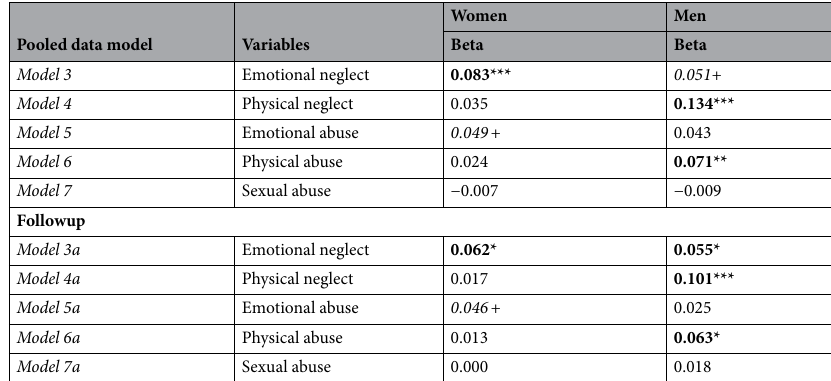
Table 4. Secondary analysis, results from the multivariable regression models with body shape as outcome— baseline: Model 3 – model 6 are showing the effect of each childhood trauma category on body shape. We could identify distinct differences between the sexes. In women, both emotional categories are predictors for an increased WHtR, while in men, the physical categories are relevant. Follow-up: Similar to the baseline, the sexes are affected by different categories. The trend was stable with emotional categories being more relevant in women, while physical trauma was more relevant in men. + p < = 0.1, *p < = 0.05, **p < = 0.01, ***p < = 0.001. Statistical significant results are highlighted in bold.